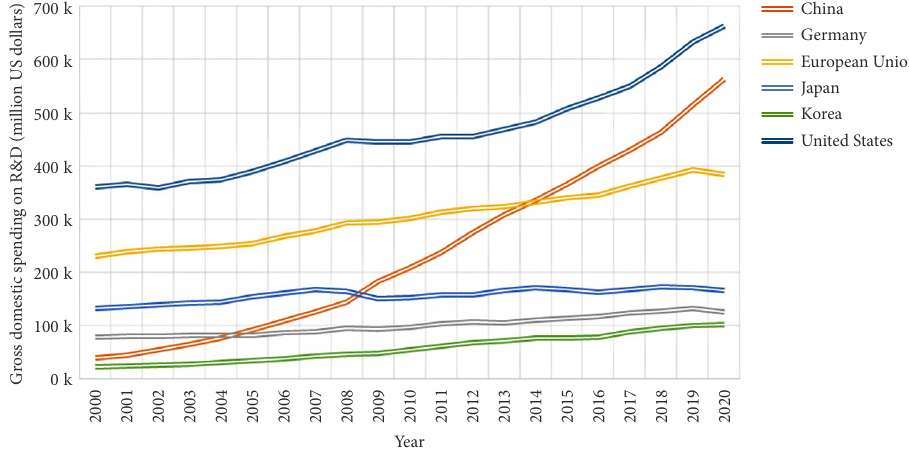
Figure 1. Trend of total R&D expenditure by countries (total, million US dollars) (source: OECD,